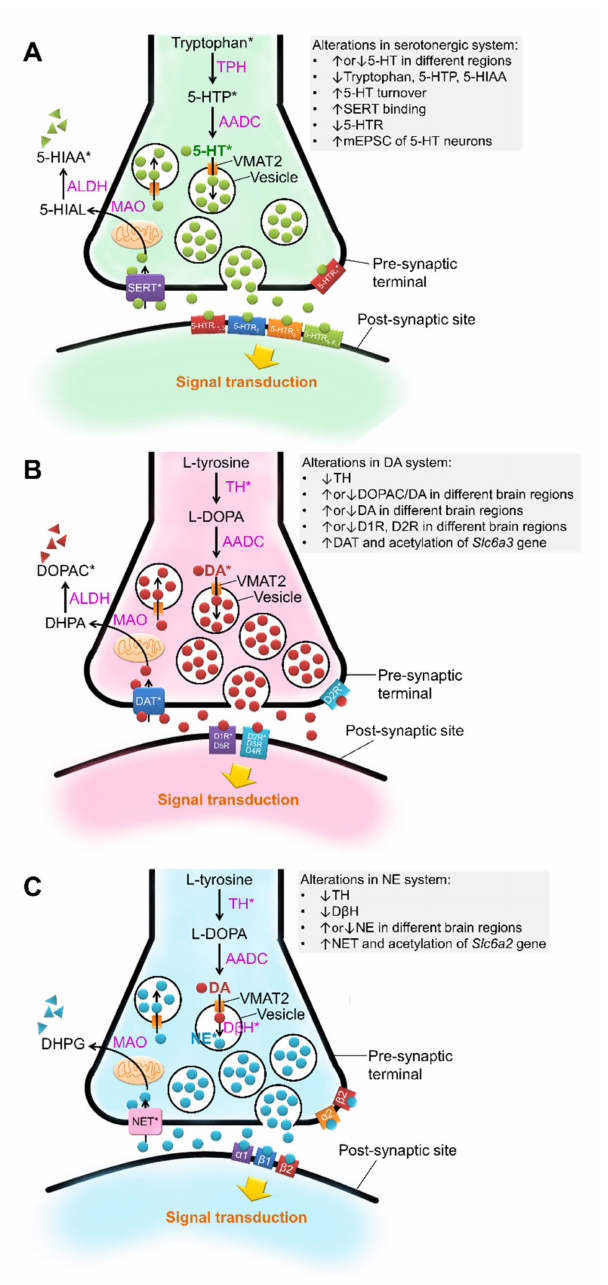
Figure 2. Schematic drawings illustrate monoaminergic neurotransmissions and their dysregulation in response to maternal VPA challenge. ( A ) Serotonergic neurotransmission. ( B ) Dopaminergic neurotransmission. ( C ) Norepinephrinergic neurotransmission. The neurotransmission molecules that are altered by maternal VPA treatments are indicated by asterisk*. Abbreviations: ↑ , increased; ↓ , decreased; 5-HIAA, 5-hydroxyindoleacetic acid; 5-HIAL: 5-hydroxyindole acetaldehyde; 5-HT, 5- hydroxytryptamine (serotonin); 5-HTP, 5-hydroxytryptophan; 5-HTR, 5-hydroxytryptamine receptor; AADC, aromatic L-amino acid decarboxylase; ALDH, aldehyde dehydrogenase; D1R, dopamine D1 receptor; D2R, dopamine D2 receptor; D3R, dopamine D3 receptor; D4R, dopamine D4 receptor; D5R, dopamine D5 receptor; DA, dopamine; DAT, dopamine transporter; D β H, dopamine- β -hydroxylase; DHPG, dihydroxyphenylglycol; DOPAC, 3,4-dihydroxyphenylacetic acid; MAO, monoamine oxidase; mEPSCs, miniature excitatory postsynaptic currents; METH, methamphetamine; NE, norepinephrine; NET, norepinephrine transporter; SERT, serotonin transporter; TH, tyrosine hydroxylase; TPH, tryptophan hydroxylase; VMAT, vesicular monoamine